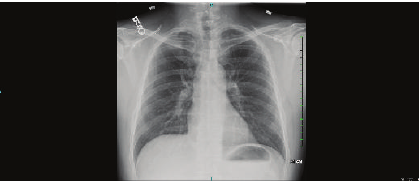
Figure 6: Chest X-ray of our patient before right first rib resection.